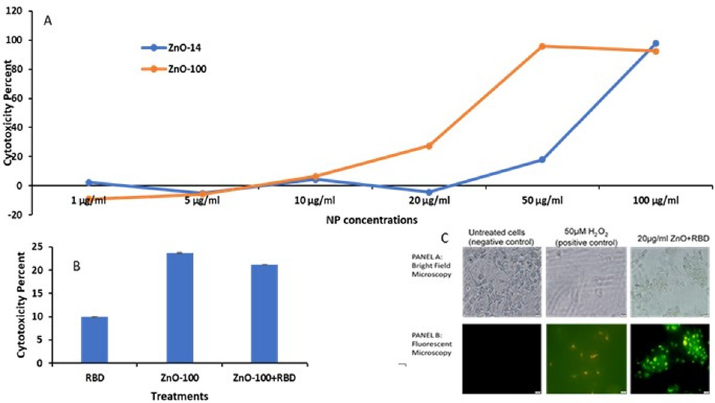
Fig 5. A. Comparative cytotoxicity in B16F10 cells in response to increasing doses of ZnO NP-100 nm and ZnO NP– 14 nm B. Comparative cytotoxicity in B16F10 cells in response to RBD-bound ZnO NP 100 nm @ 20 μ g/ml C. Bright field microscopic images (panel A) and fluorescence microscopic images (panel B) of B16F10 cells after 24 h exposure to ZnO + RBD.